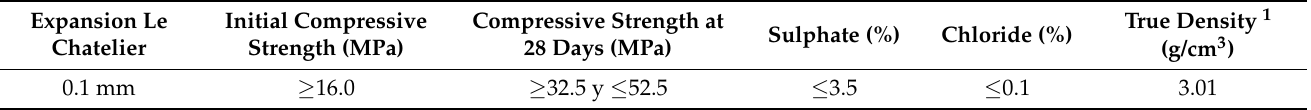
Table 1. Most relevant physical and chemical characteristics of CEM cement IV/B (P-V) 32.5 N. Expansion Le